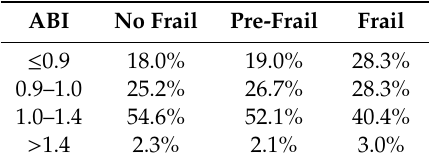
Table 3. Distribution of ABI among no frail, pre-frail and frail participants of the Toledo Study for Healthy Aging